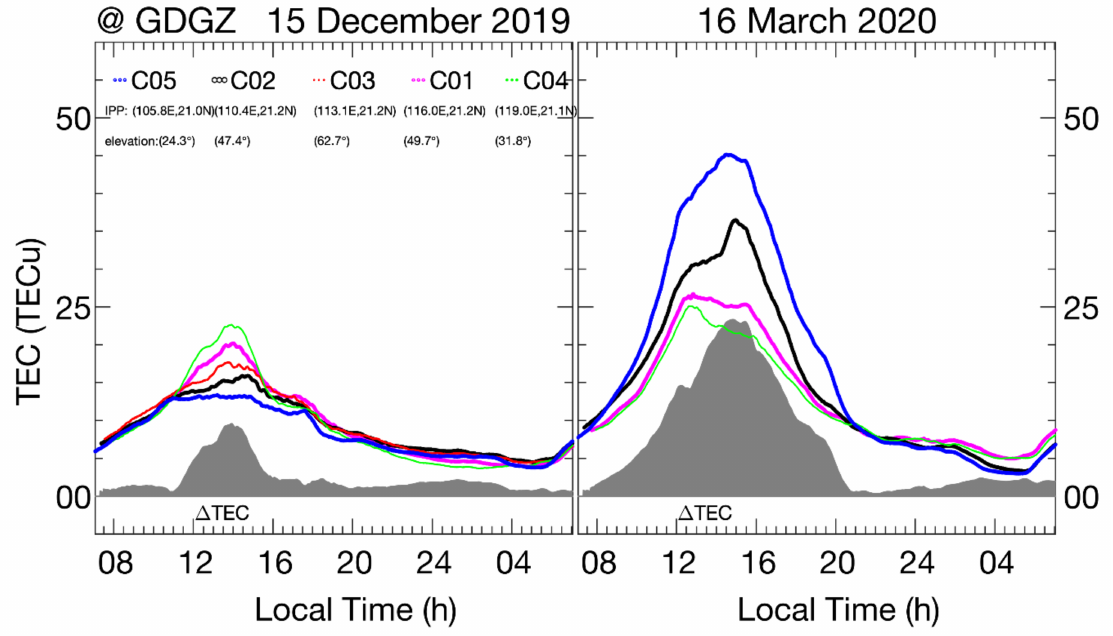
Figure 9. Local time variation of the TEC of the five GEO IPPs recorded at GDGZ on 15